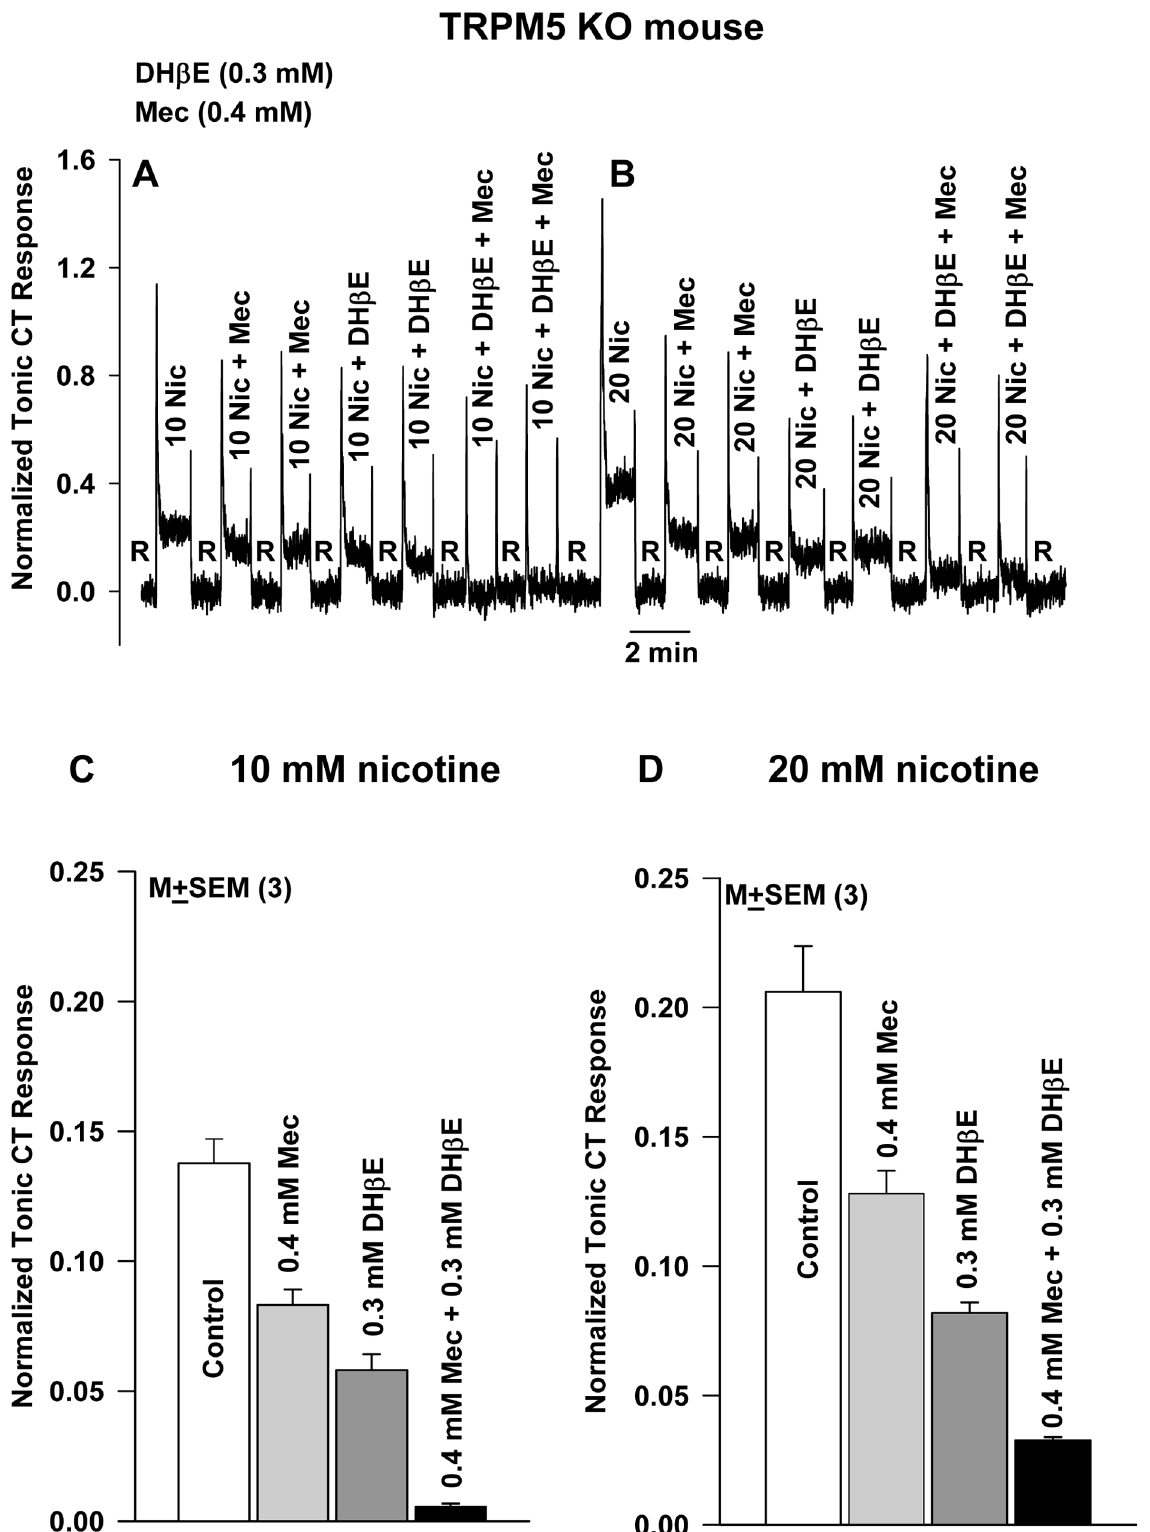
Fig 2. Effect of DH β E and Mec on the CT response to nicotine in TRPM5 KO mice. This shows a representative normalized CT response in a TRPM5 KO mouse in which the tongue was first rinsed with distilled H 2 O (R) and then stimulated with 10 mM (A) or 20 mM (B) nicotine in the absence and the